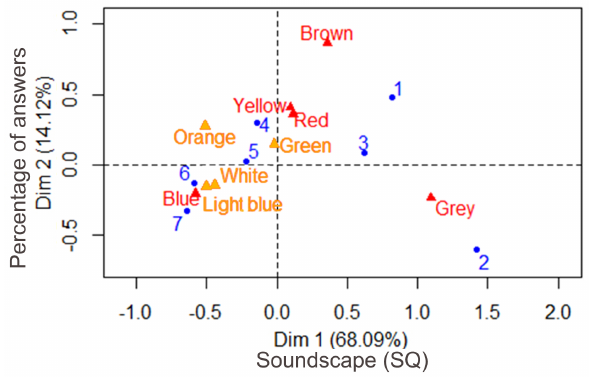
Figure 10: Correspondence analysis between soundscape (SQ) and colours associated to it. Blue dots represent the SQ ratings, red triangles the colours with a contribution higher than the 11.1%, and orange triangles those with a contribution lower than the